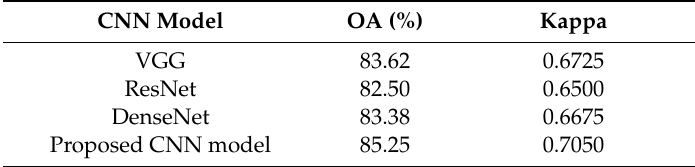
Table 6. Comparison with classical CNN models using only limited